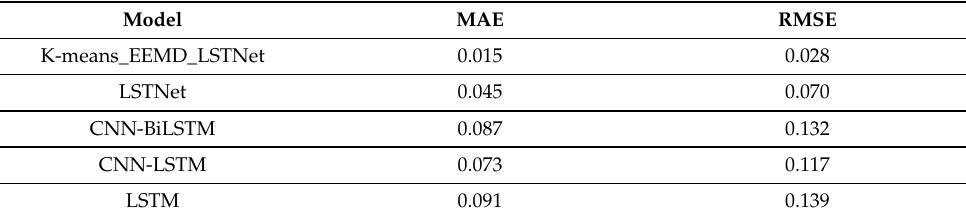
Table 5. The prediction index comparison of LSTM, CNN-LSTM, CNN-BiLSTM, LSTNet and K- means-EEMD-LSTNet load forecasting